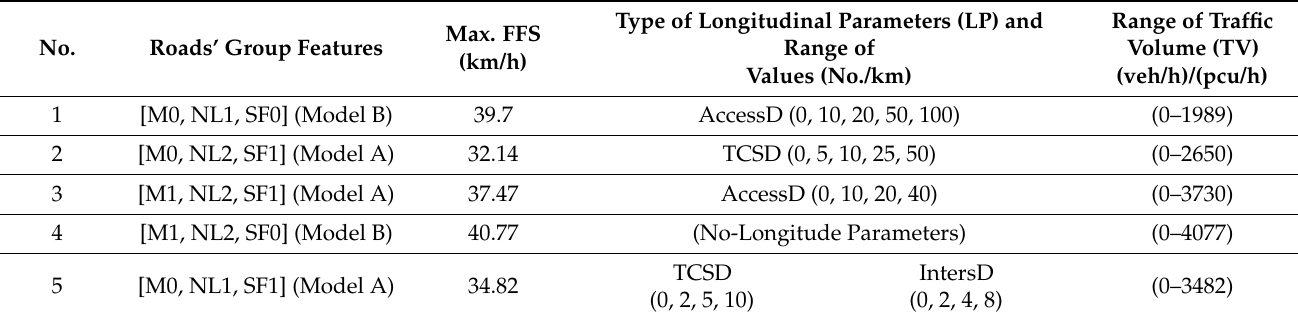
Table 7. Scenarios for models’